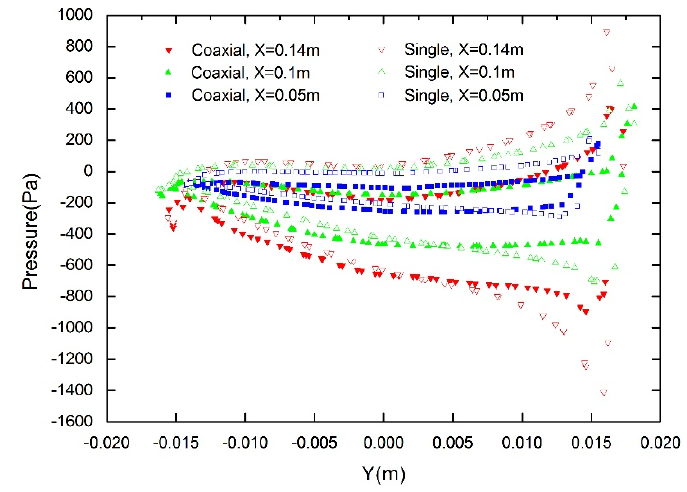
Figure 18. Surface pressure of ducted single and coaxial upper propellers.